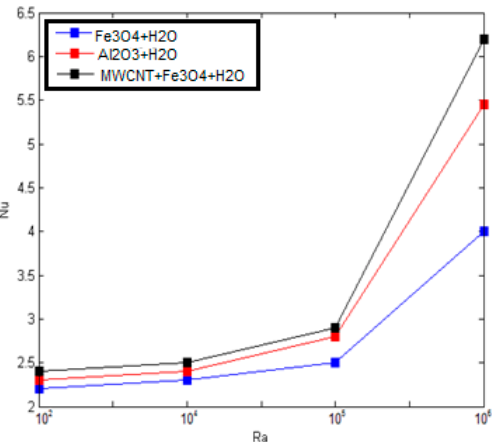
Figure 8. The Nusselt number survey relative to the volume of nanoparticles at Ha = 40, AR = 0.5, and α = 0.